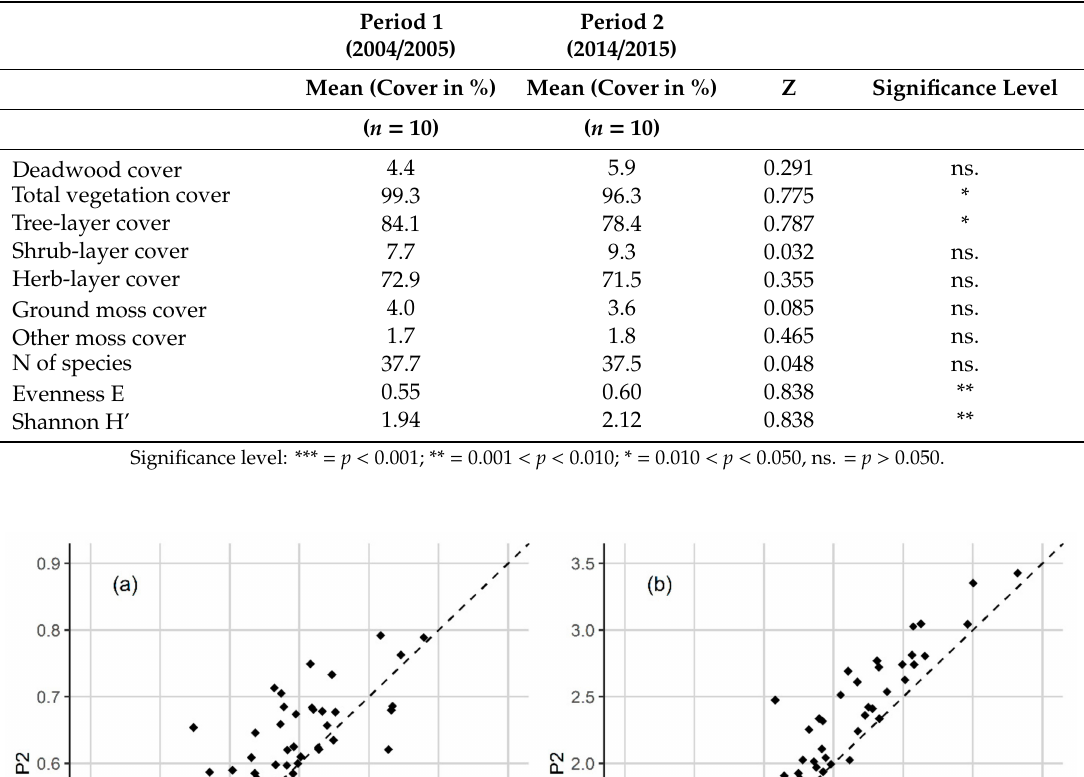
Table 3. Comparison of site-scale variables between the two monitoring periods (P1: years 2004 / 2005, P2: years 2014 / 2015), including results of the Wilcoxon Matched Pairs Test.